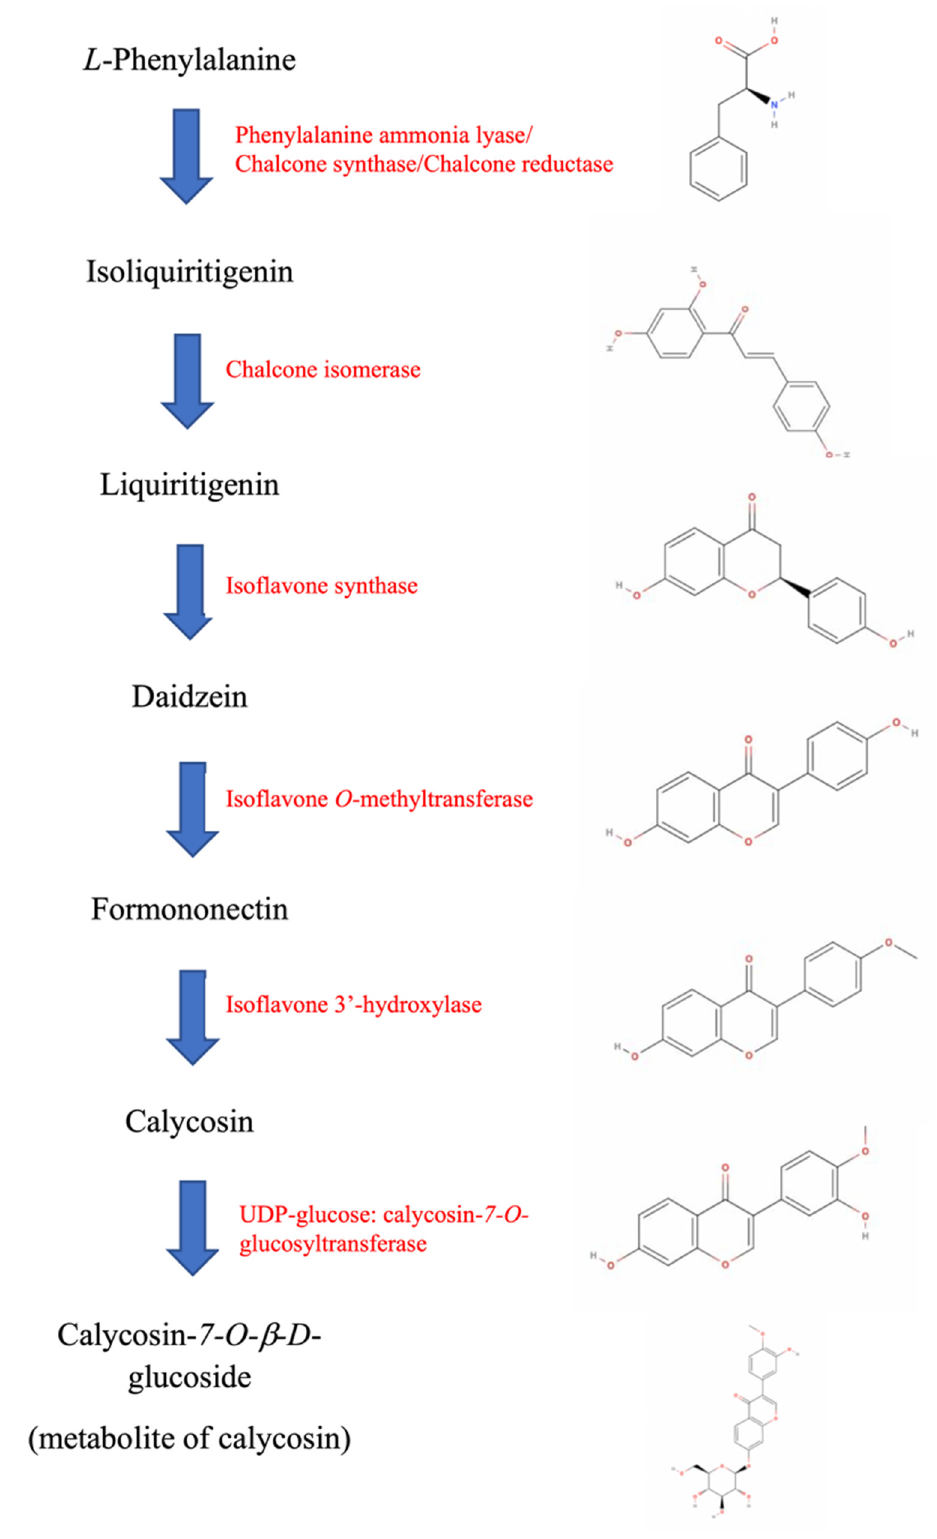
Figure 2. Biosynthetic pathway of herbal isoflavonoids—the ISL-calycosin cascade.